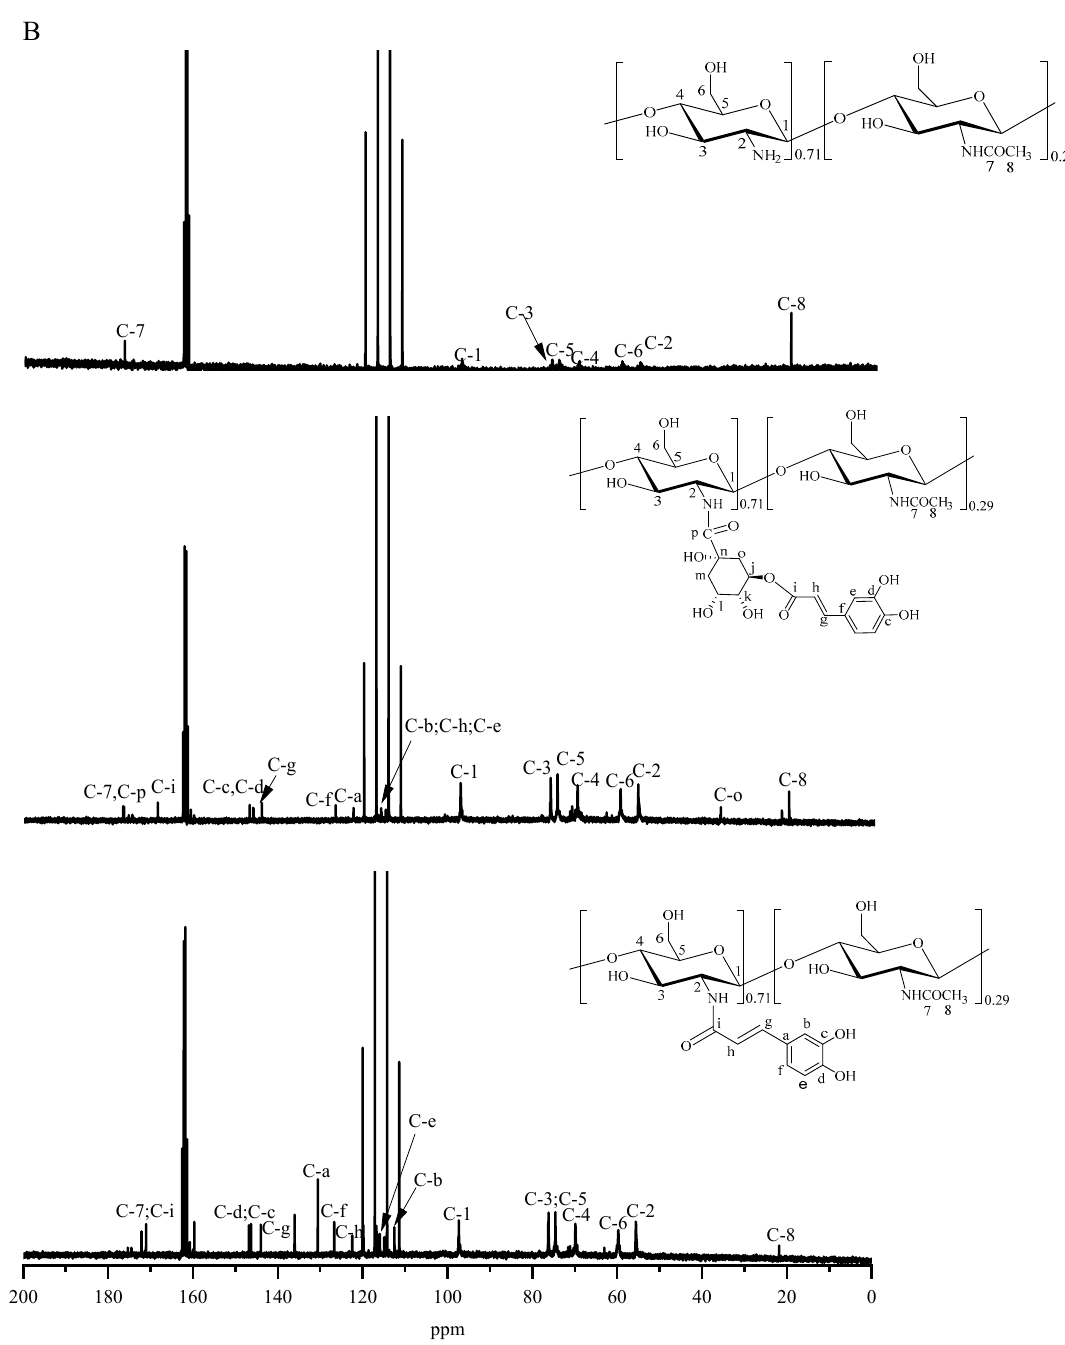
Figure 2. 1 H NMR spectra of CS and phenolic acid-CS (A); 13 C NMR spectra of CS and phenolic acid-CS (B).